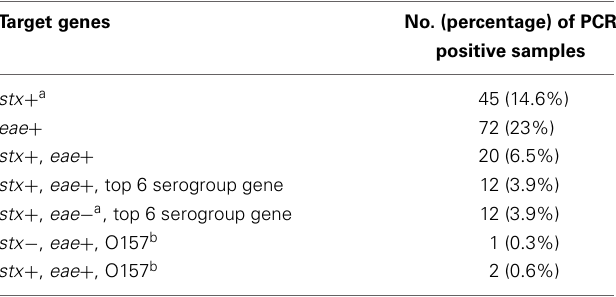
Table 2 | Distribution of stx and eae virulence genes in 308 retail beef